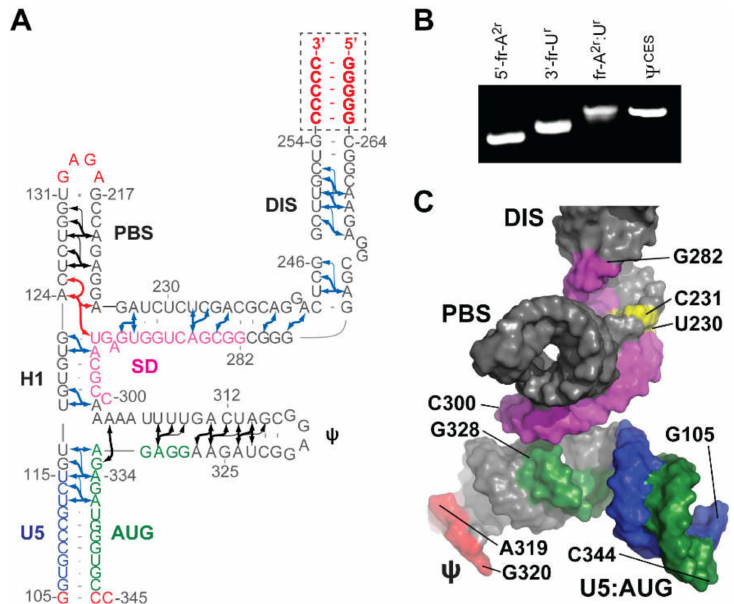
Figure 7. NMR structure of HIV-1 NL4-3 Ψ CESm . ( A ) Fragment-annealed sample used to identify long-range adenosine-H2 detected NOEs (denoted by arrows). Non-native residues are shown in red; U5, blue; AUG, green; and SD, pink. ( B ) Native polyacrylamide gel electrophoresis showing non-covalent annealing of di ff erentially labeled 5 (cid:48) - and 3 (cid:48) - fragments. ( C ) Representation of the tandem three-way junction NMR structure adopted by Ψ CESm (colors match panel A ; conformationally dynamic nucleotides, yellow; Ψ tetraloop, orange). Adapted from [41], with